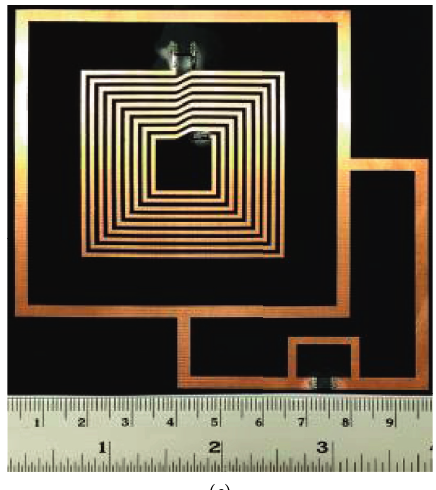
Figure 12: The integrated HF-RFID and UHF-RFID tag antenna: (a) configuration, (b) magnetic field distribution in HF band, and (c) prototype antenna.